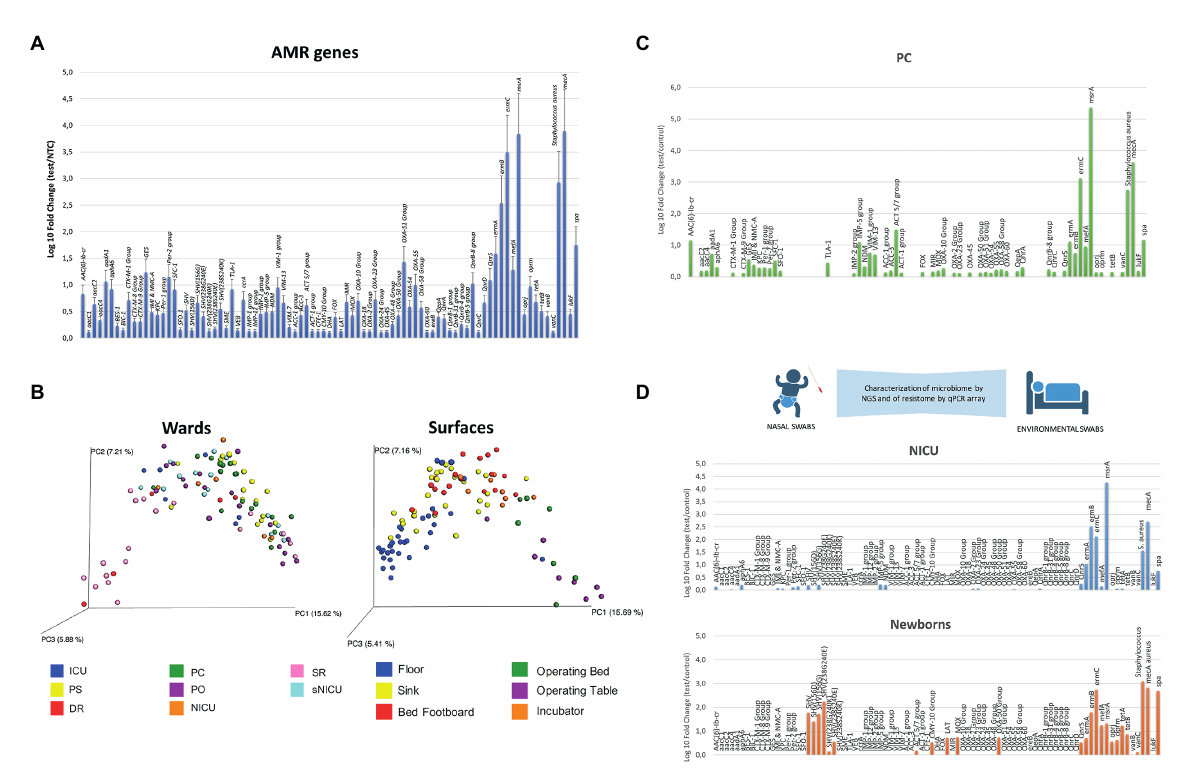
FIGURE 1 Characterization of the hospital microbiome and its AMR. (A) Detection of AMR genes and Staphylococcus aureus presence by real-time quantitative (qPCR) microarray. The results represent the mean values detected in the General Medicine wards of 12 Italian hospitals from 2015 to 2020, and are expressed as mean ± SE. Log 10 fold change values for each gene compared to negative controls. In addition to AMR genes, S. aureus and two of its virulence factors ( spa and lukF ) are also identified by the microarray. (B) NGS characterization of the microbial communities residing on different types of surfaces in the wards of a pediatric hospital. The unifrac-based principal coordinates analysis (PCoA) plots show the clustering of bacterial communities according to the wards (A) and surfaces (B) investigated. Each dot represents a sample. PC, Pediatric Clinic; PS, Pediatric Surgery; NICU, Neonatal Intensive Care Unit; sNICU, sub-Intensive Care Unit; ICU, children’s Intensive Care Unit; SR, Surgical Rooms; DR, Delivery Room; PO, Pediatric Oncology. (C) Detection of AMR genes by qPCR microarray in the Pediatric Clinic ward of a children’s hospital. The results are expressed as log 10 fold change values compared to negative controls. (D) Colonization of preterm infants by Neonatal Intensive Care Unit (NICU) environmental microorganisms; the AMR analysis was performed by qPCR microarray. The results are expressed as log 10 fold change values compared to negative controls, relative to the NICU environment (NICU) and to the newborn’s nasal cavity after 2 weeks of hospitalization in NICU